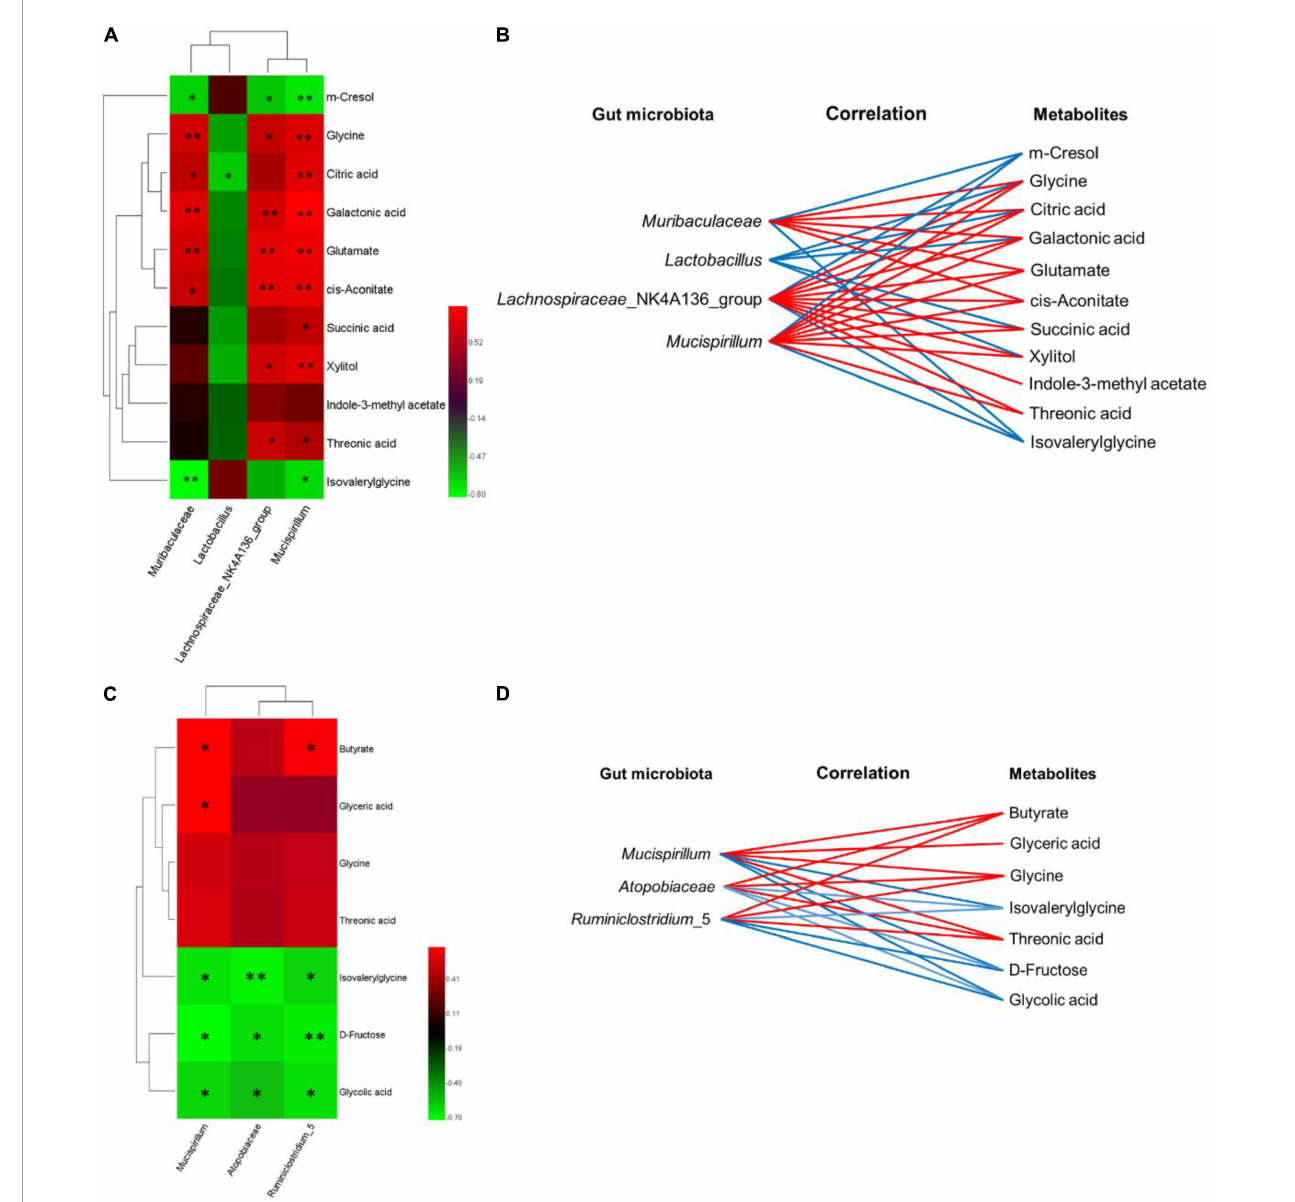
FIGURE7 The relevance between the gut microbiota of genus level and the differential urinary metabolites. (A–C) Spearman’s correlation heat map: red indicates a positive correlation, while green indicates a negative correlation. The deeper color means a greater correlation ( ∗ P < 0.05, ∗∗ P < 0.01). (B–D) The gut microbiota of the genus level, predicted by metabolic variation (|r| > 0.4), is labeled with a similar value. Lines connecting with metabolites show the direction of the relevance to each genus of microbe with the red (positive) or blue (negative) lines, N = 6.